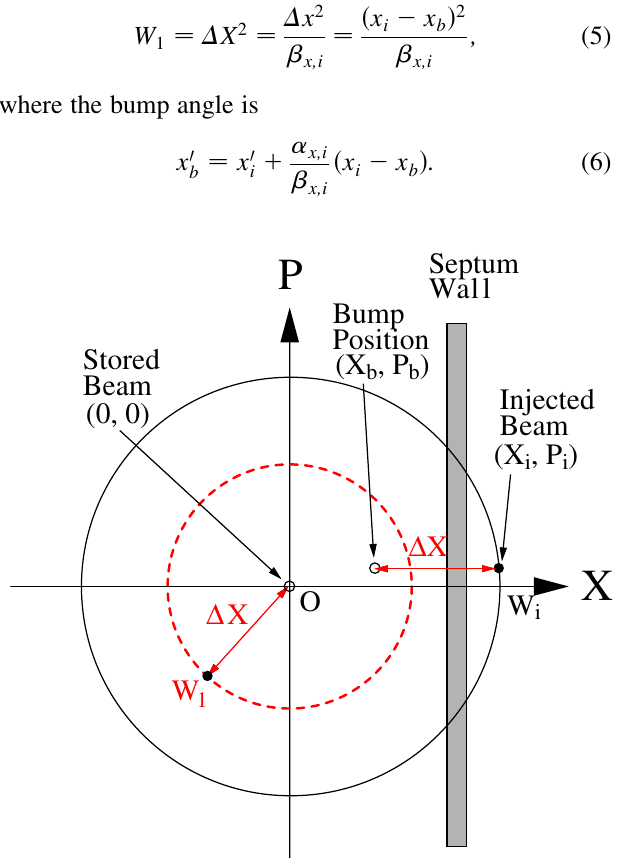
FIG. 3. (Color) Trajectories of the injected and stored beams using a pulsed local bump are displayed in the normalized phase space. The closed and open circles denote the injected and stored (cid:4) are the coordinates of the injected ; P beams, respectively. (cid:3) X i i (cid:4) are the coordinates of the bumped orbit of the ; P beam and (cid:3) X b b stored beam at the injection point. (cid:1) X is the difference between and W indicate FIG. 4. (Color) Same as Fig. 3, but the trajectories are generated the injection position and the bump position. W i 1 the injection invariant and the reduced invariant, respectively. by four kickers to give the closed local bump. The closed and The rectangle shows the septum wall as a horizontal physical open circles indicate the injected and stored beam, and the aperture. dashed and dotted lines show their trajectories,